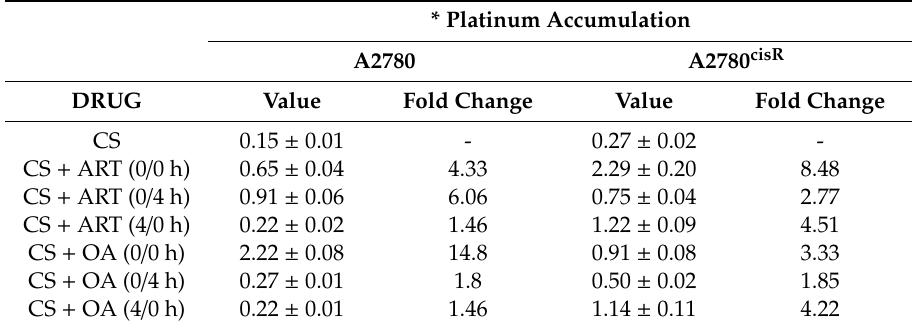
Table 5. Platinum accumulation level of CS alone and in combination with ART and OA.